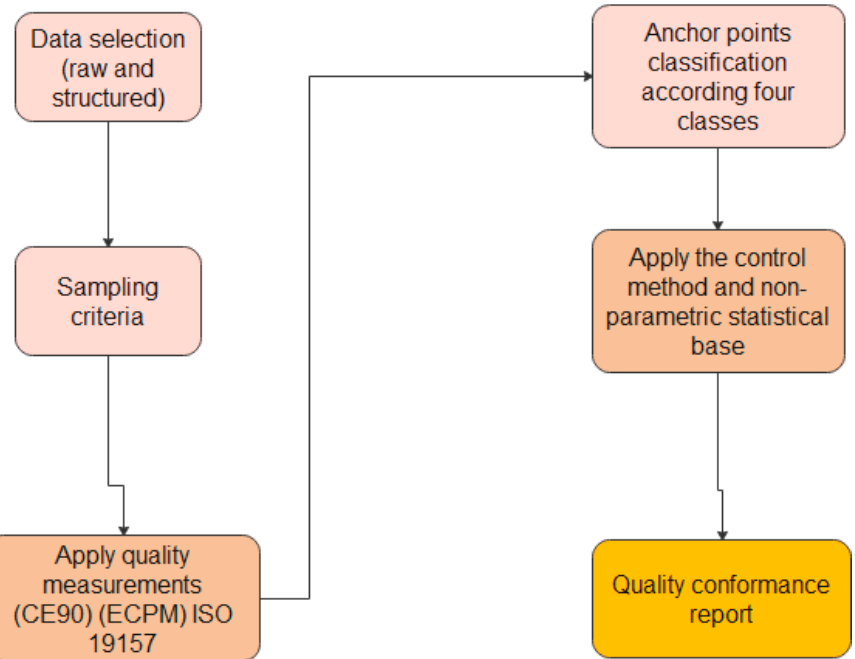
Figure 5. Procedure to evaluate positional accuracy quality element for FFPLA.